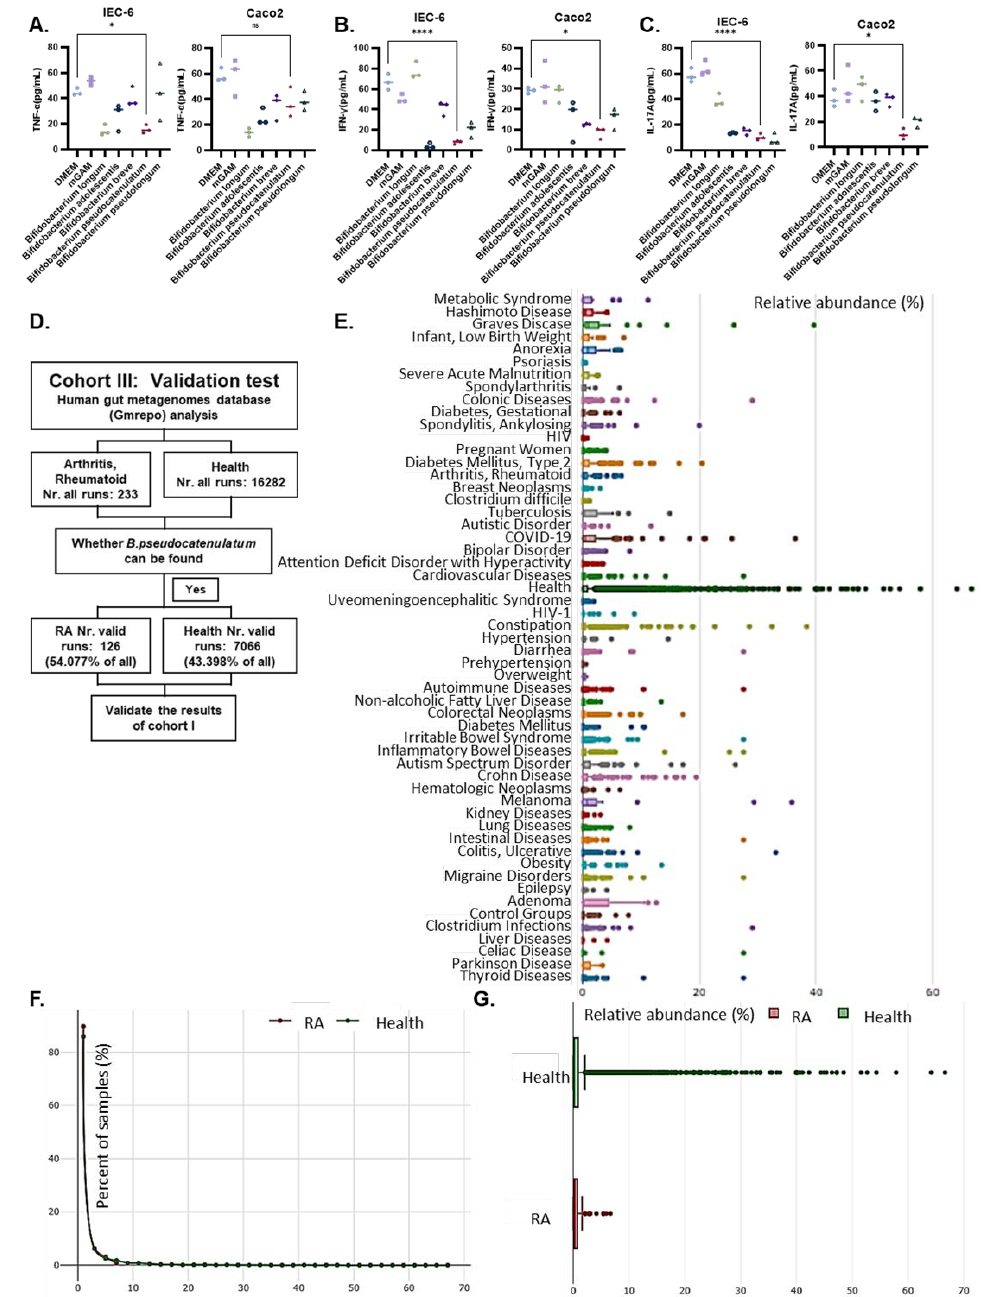
Figure 2. Co-culture experiments to identify specific Bifidobacterium strains and validate their function in the metagenomes database. ( A – C ) ELISA assay for the expression levels of TNF- α , IFN- γ , and IL-17A in culture supernatants of LPS-stimulated IEC-6 and Caco-2 cells were treated with 5 different Bifidobacterium strains. B. pseudocatenulatum significantly inhibited inflammatory cytokine secretion. Values are presented as means ± SD. A one-way ANOVA was used to compare values among multiple groups. Significant results are indicated as: * p < 0.05, **** p < 0.001, ns, non-significant. ( D ) Another validation cohort based on information from the metagenomes database of RA patients and healthy individuals. ( E ) Boxplot of the relative abundance of B. pseudocatenulatum in GMrepo, which was expressed in the healthy group above all disease groups. ( F , G ) Relative abundance of B. pseudocatenulatum in RA patients and healthy individuals verified in GMrepo.